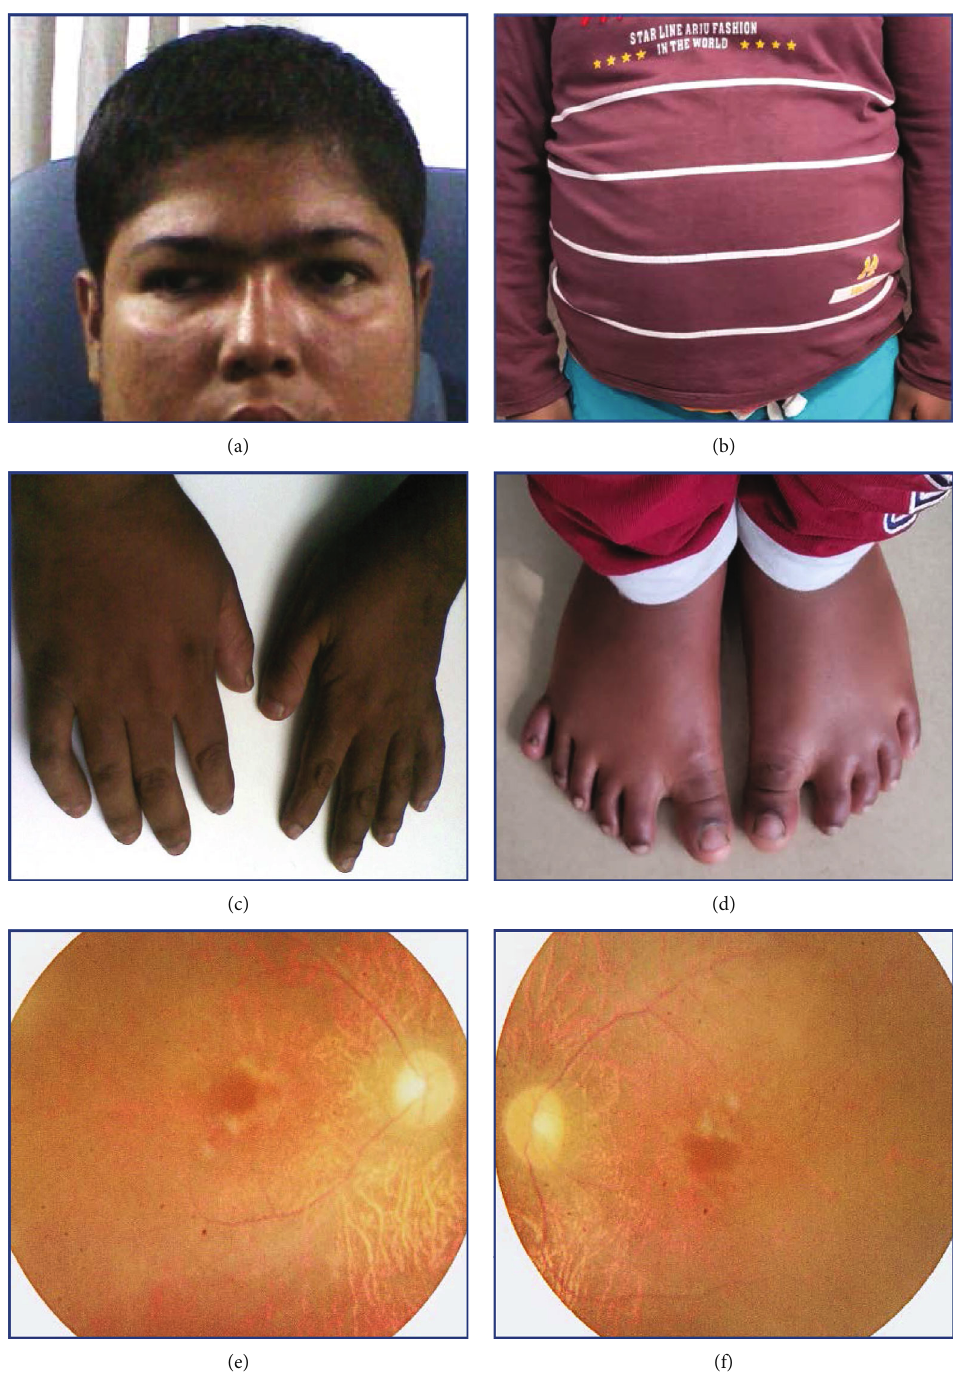
Figure 2: (a) Divergent squint. (b) Central obesity. (c) Short, broad, and stubby fi ngers of the upper limbs. (d) Polydactyly, syndactyly, and brachydactyly in the lower limbs. (e, f) Fundus images of the right and left eyes showing mild arteriolar attenuation with pigmentary retinopathy and pale optic